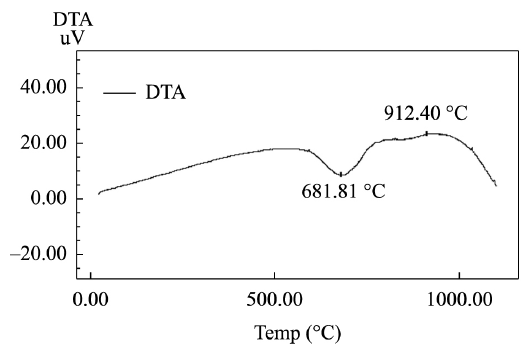
Figure 2. Differential thermal analysis (DTA) curve for Ti-coated